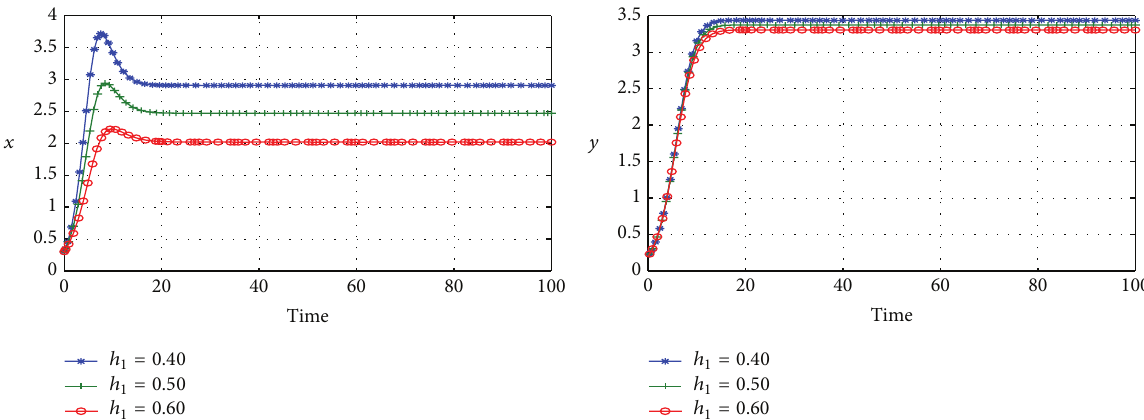
Figure 4: When ℎ 2 = 0.5 and ℎ 1 increases, prey species 𝑥 and predator species 𝑦 decrease.